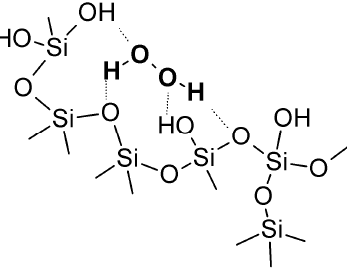
Figure 2. Spectroscopic characterization of silica xerogel-hydrogen peroxide composite: ( A ) FTIR spectrum, ( B ) Raman